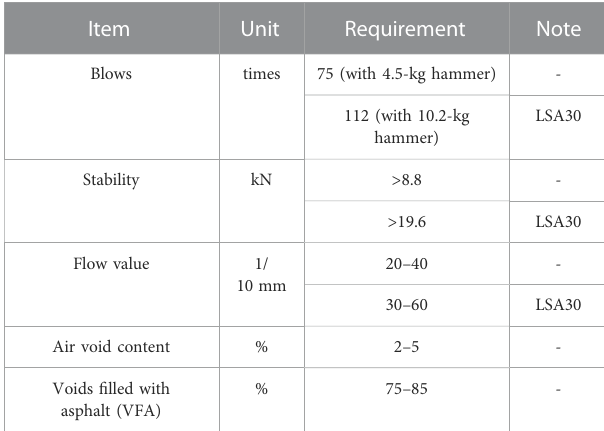
TABLE 4 Requirements for the Marshall design